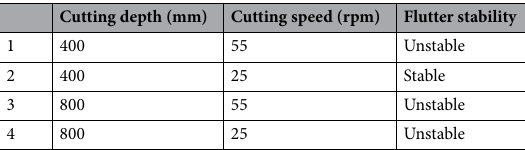
Table 5. Cutting parameter setting.